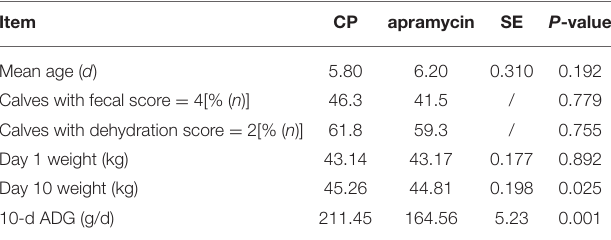
TABLE 1 | The characteristics of calves in a randomized clinical trial on the effect of CP and apramycin on the treatment of calves for diarrhea.